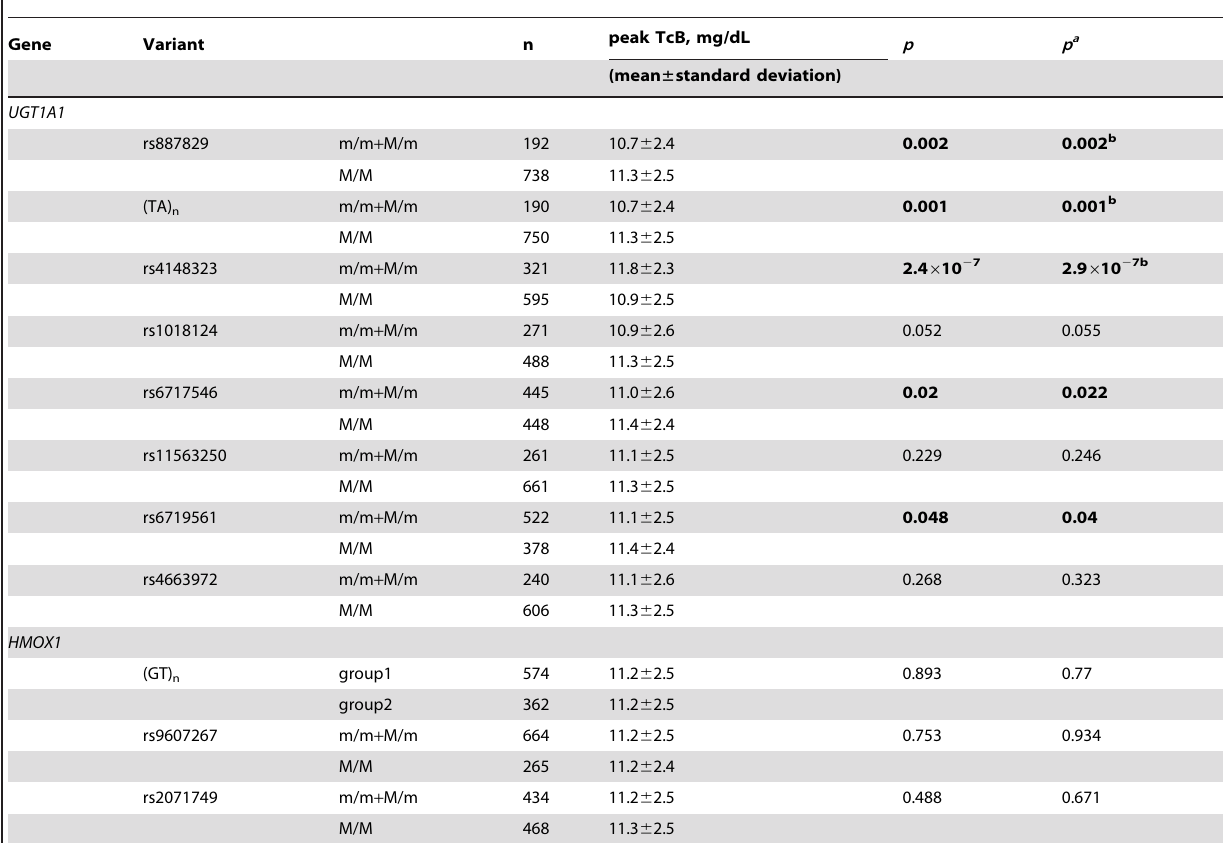
Table 6. Comparison of peak TcB between different genotypes.